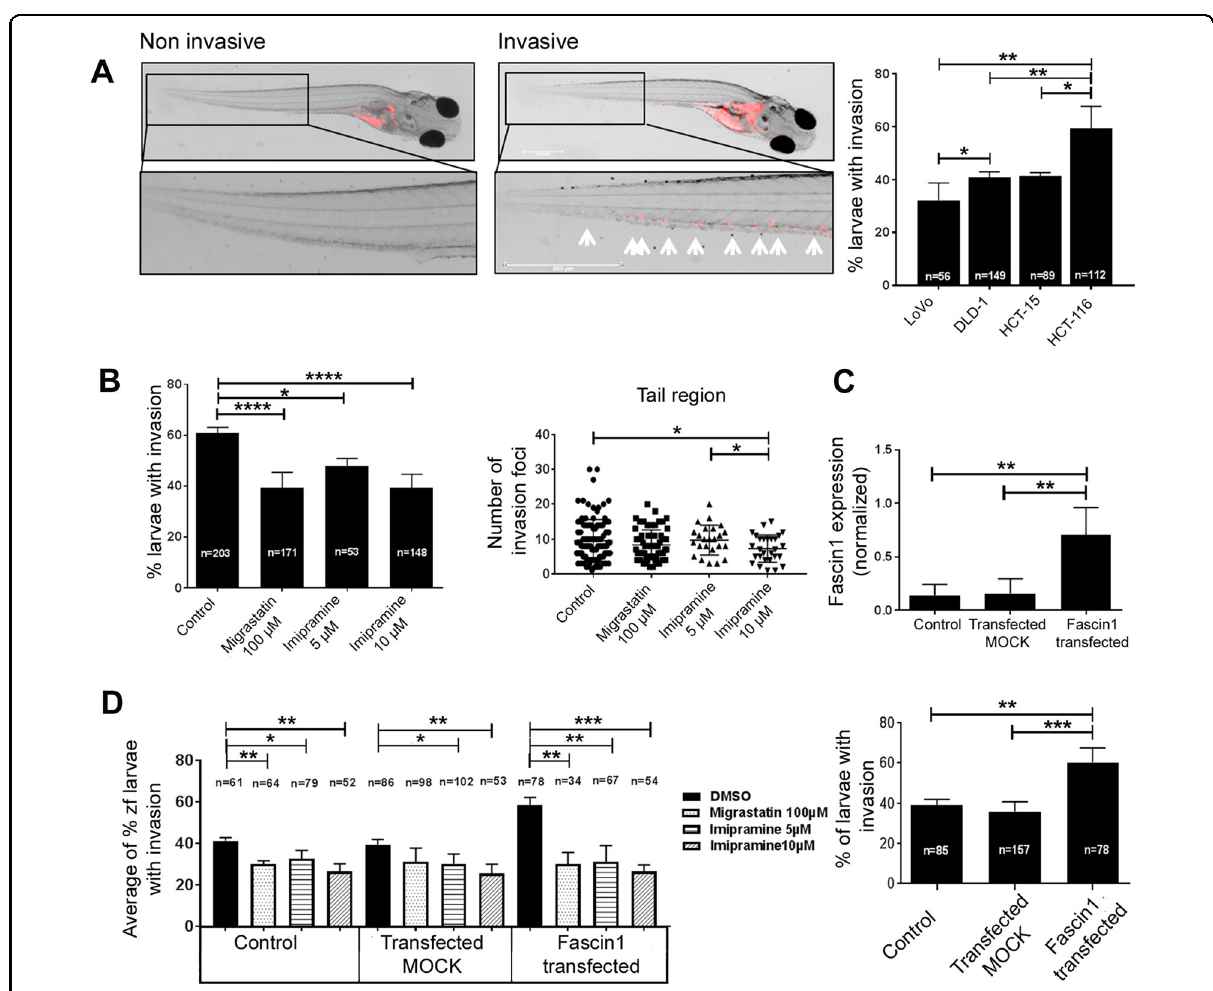
Fig. 7 Zebra fi sh invasion assays 4 days post xenograft. a The images show the invasive and noninvasive cells in a zebra fi sh invasion model. The invasiveness of each cell line in this model is shown in the right panel. b HCT-116 cancer cells were treated with migrastatin and imipramine and then injected into zebra fi sh larvae. The effect of imipramine in diminishing the cell invasion percentage and the number of invasive cells is similar to that of migrastatin. c Fascin1 mRNA levels in transfected DLD-1 cells and cell invasion associated with transfection (lower panel). d Effect of drugs on the average percentage of zebra fi sh larvae invasion in fascin1-transfected DLD-1 cells. Data are shown as the mean ± SD, compared with the control, * p = 0.049 – 0.01; ** p = 0.001 – 0.009; *** p = 0.0001 – 0.0009; **** p <